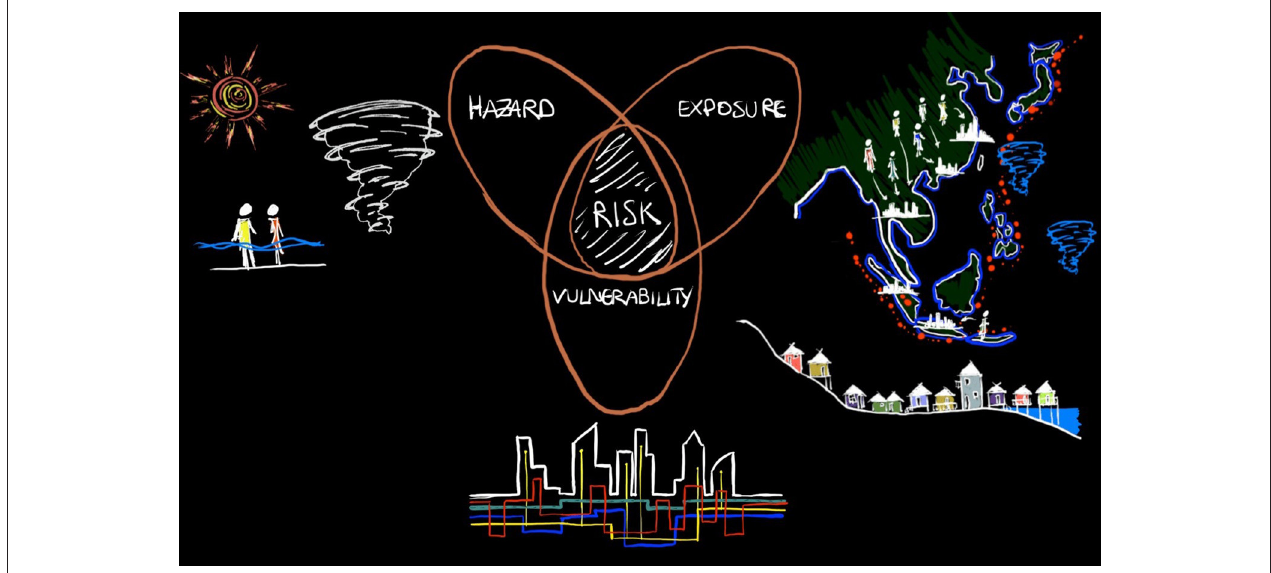
FIGURE 1 | Risk from earthquakes is the combination of natural hazard, exposure, and vulnerability (Lallemant, 2017).